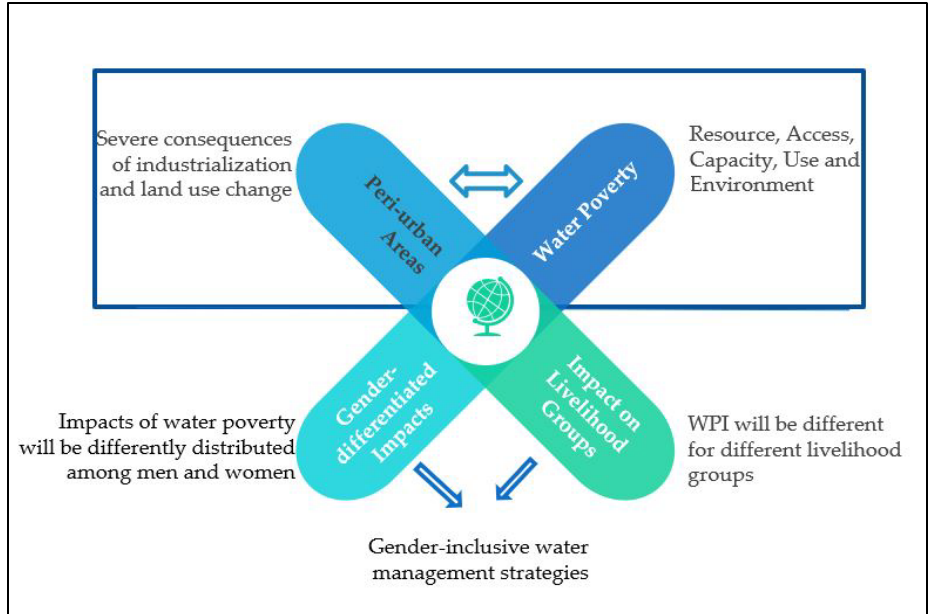
Figure 1. Conceptual framework of the present study.